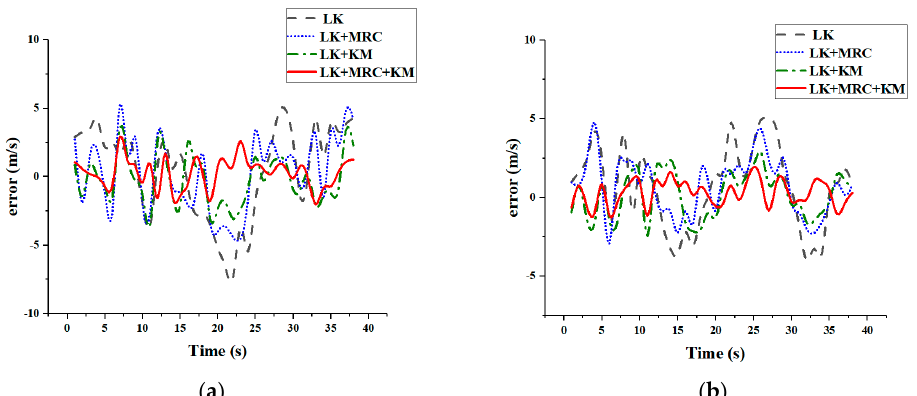
Figure 10. ( a ) The image in experiment 2; ( b ) the result of instance segmentation; ( c ) covering the objects with similar color masks.